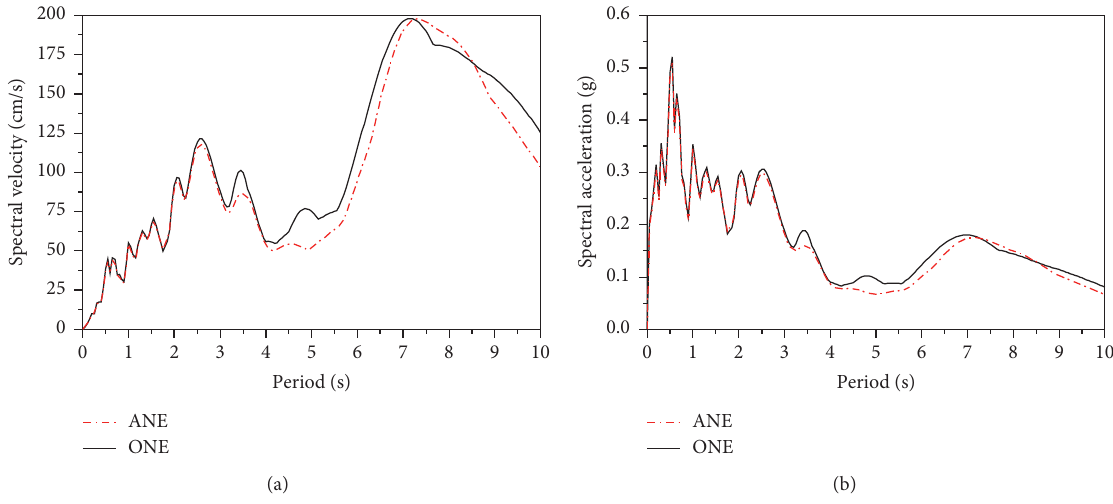
Figure 7: Response spectra of the ANE record and the ONE record: (a) velocity spectra; (b) acceleration spectra.